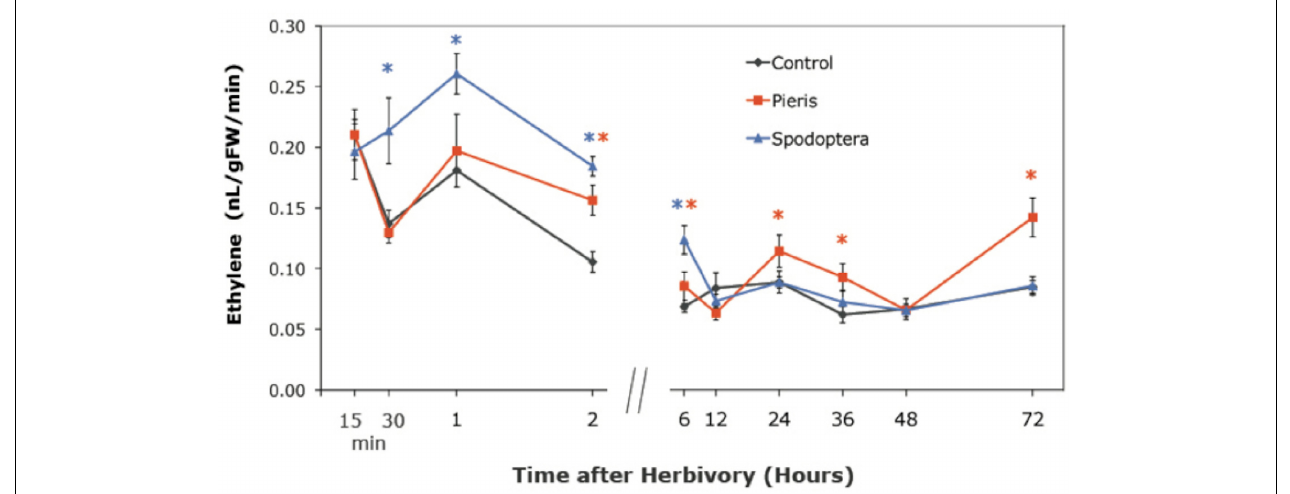
FIGURE 1 | Ethylene production in WT Arabidopsis plants after short-term P. rapae and S. exigua feeding over a 72-h time course-Ethylene was measured by Gas Chromatography as